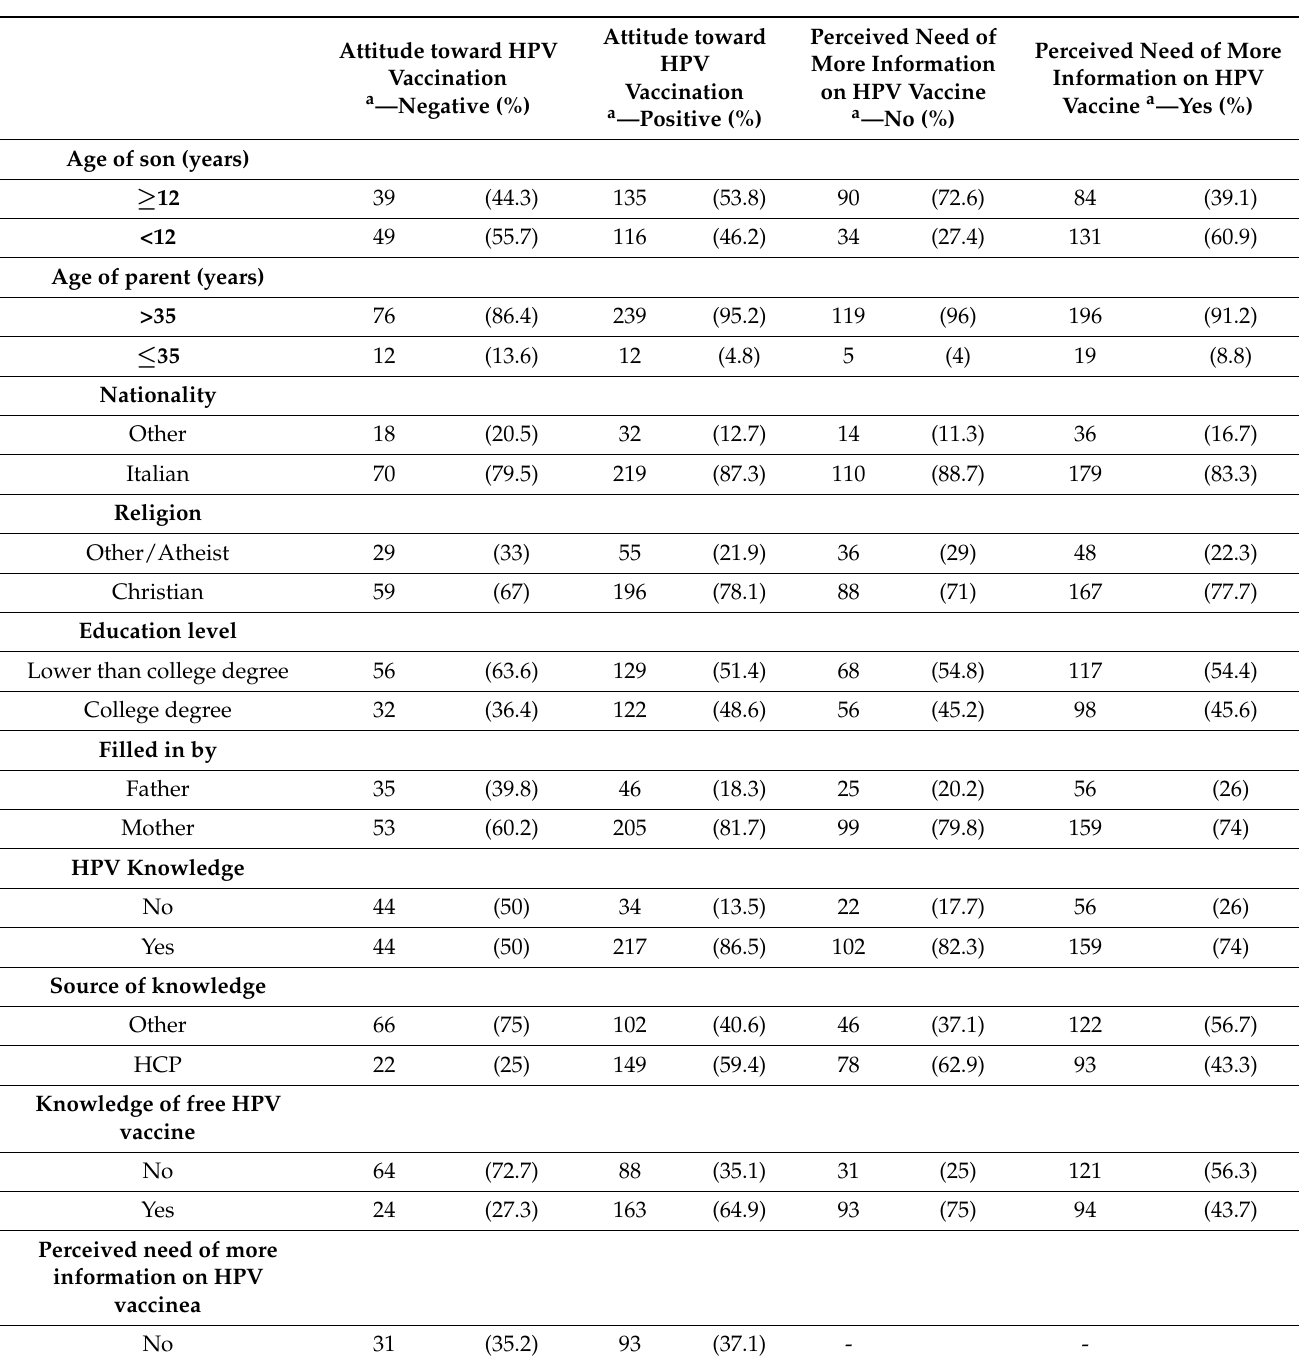
Table 3. Distribution of attitude toward HPV vaccination or perceived need of more information on HPV vaccine according to selected variables. Perceived Need of Attitude toward Perceived Need of More Attitude toward HPV More Information HPV Information on HPV Vaccination on HPV Vaccine Vaccination a —Negative (%) Vaccine a —Yes a —No (%) a —Positive (%)